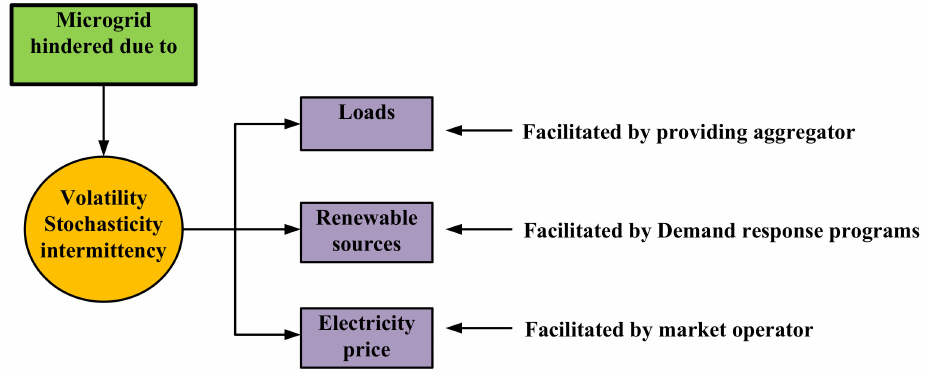
Figure 4. Stochasticity in